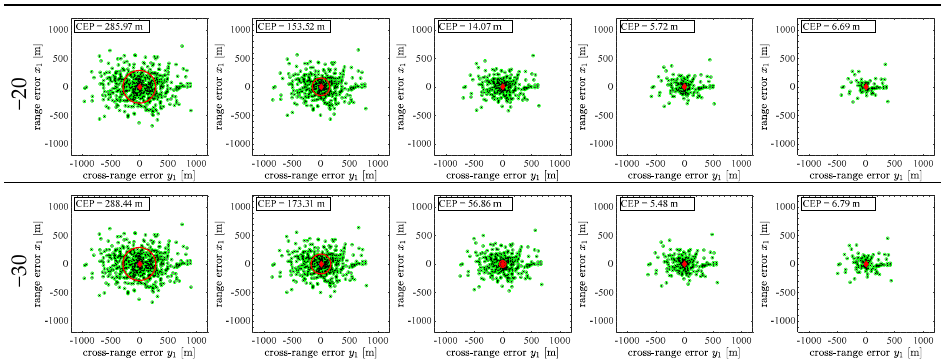
Figure 19. Dispersion patterns (nominal launch angle Θ 0 = 50 ◦ ). The obtained values of CEP are presented in Figure 20.